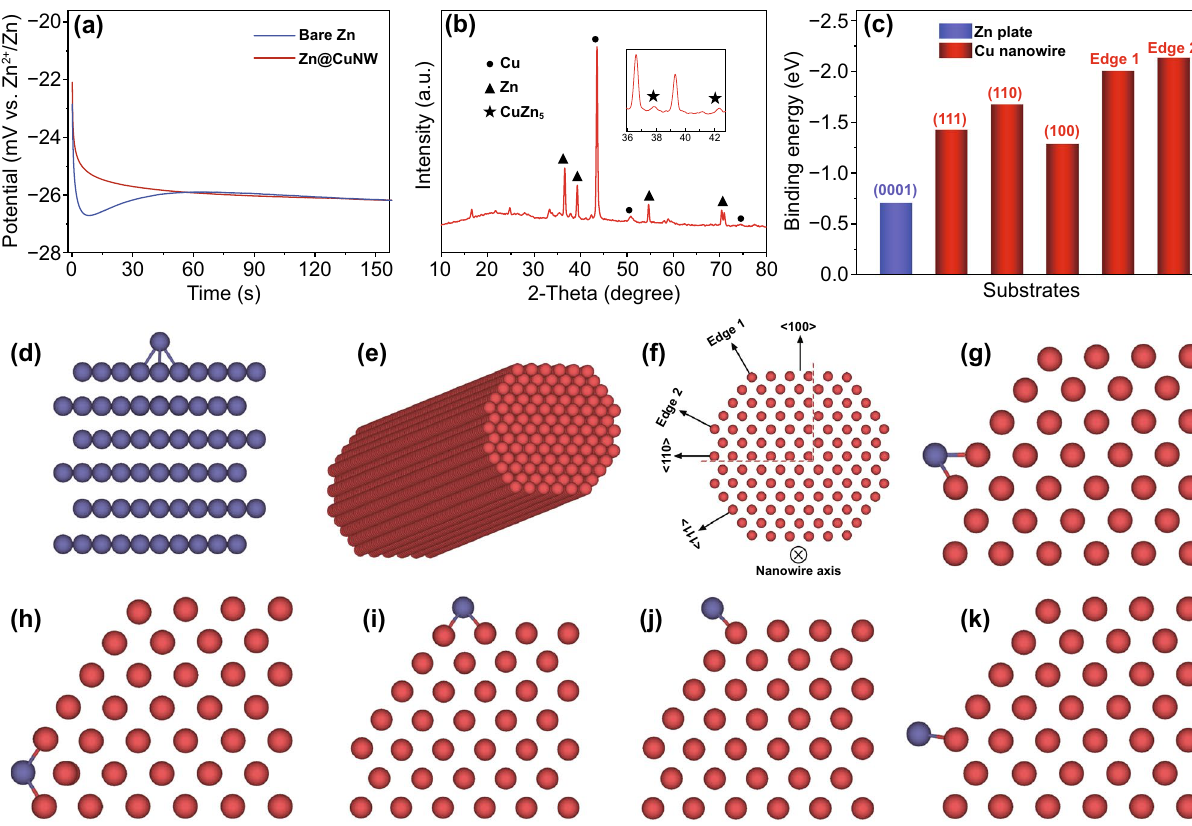
Fig. 4 a Zinc deposition curves at 0.1 mA cm −2 on bare Zn anodes and Zn@CuNW anodes. b XRD pattern (inset: enlarged zone) of CuNW/ membrane after depositing 1 mAh cm −2 zinc on the Zn@CuNW electrodes. c Binding energies between the zinc atom and different substrates of Zn plate and Cu nanowires. d Calculation model of zinc absorbed on (0001) facet of Zn plates. e Bird view and f atomic model of the single- crystalline Cu nanowire. Stable adsorption sites for one zinc atom on various facets and edges of the Cu nanowires: g (111) facet, h (110) facet, (i) (100) facet, j edge 1 and k edge 2. The Lyons blue and brownish red balls are Zn and Cu atoms,